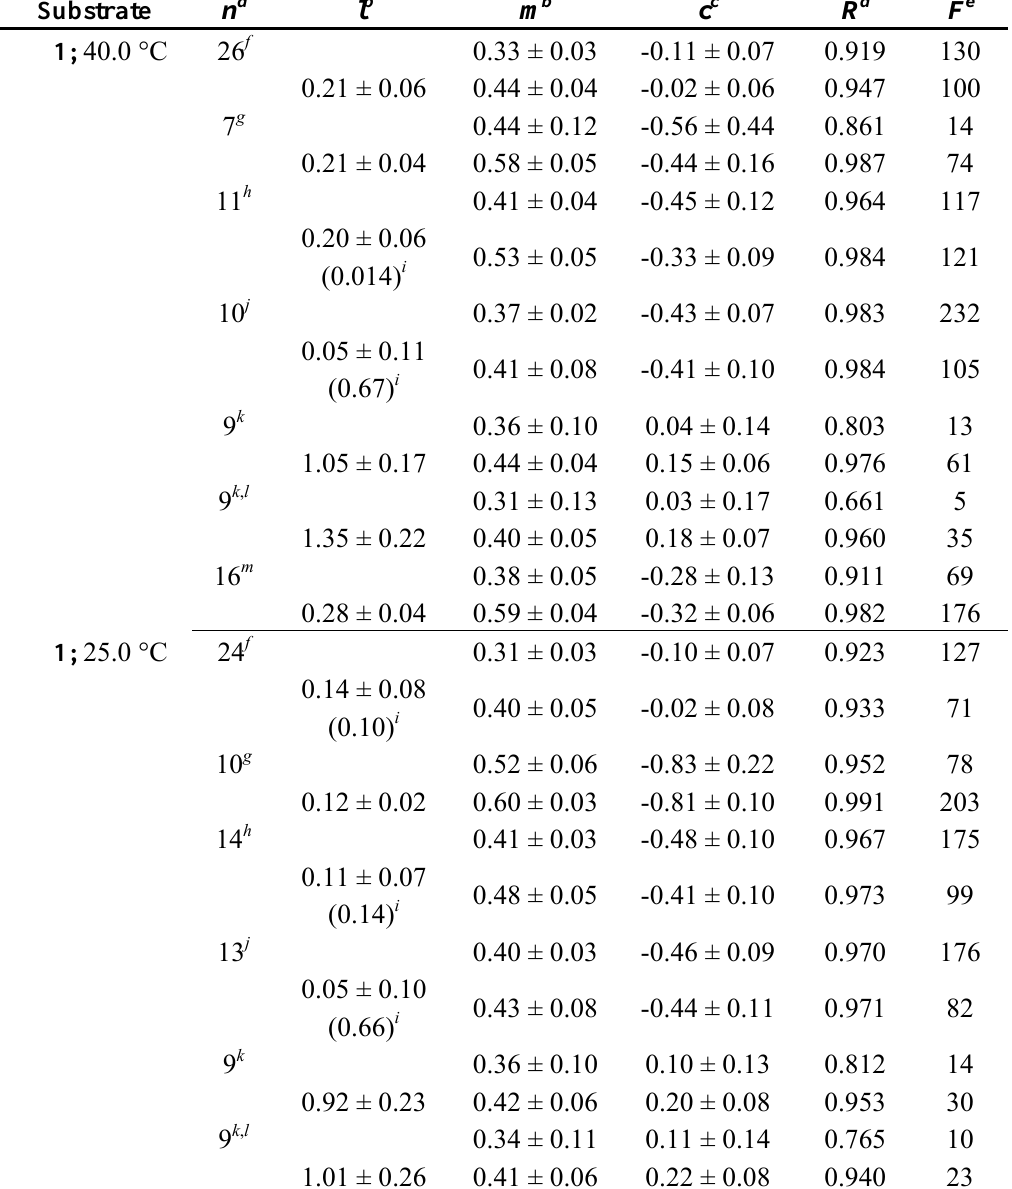
Table 3. Correlation of the specific rates of reaction of 1 , at 40.0 °C and 25.0 °C, using the simple or extended Grunwald-Winstein Equations (Equations 1 and